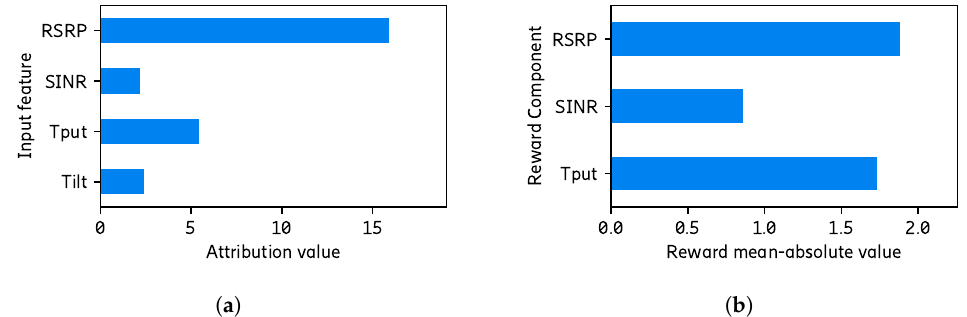
Figure 4. Explanations generated using the available XAI methods. ( a ) Feature importance generated using [6], which produces similar explanation format as [4,5]. ( b ) Reward components summary generated using [8].